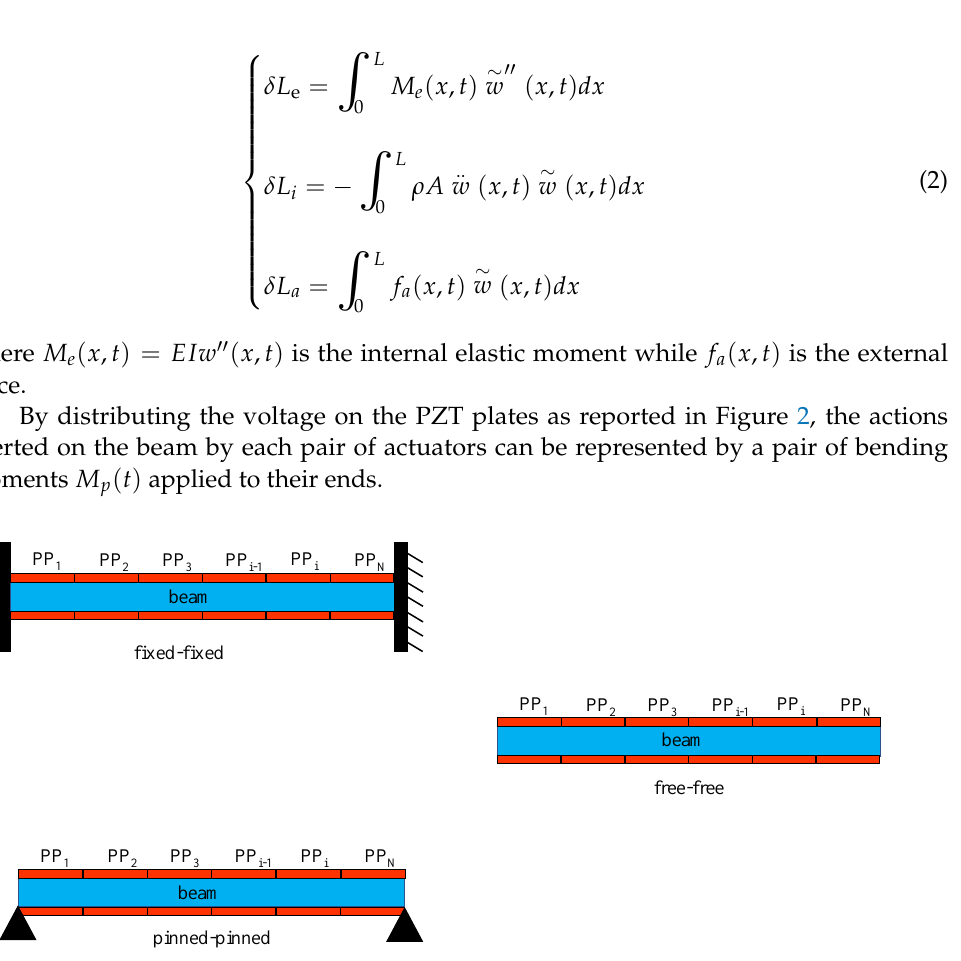
Figure 1. Beams coupled with PZT actuator pairs (PPs) for different boundary conditions: free-free, fixed-fixed, and pinned-pinned.